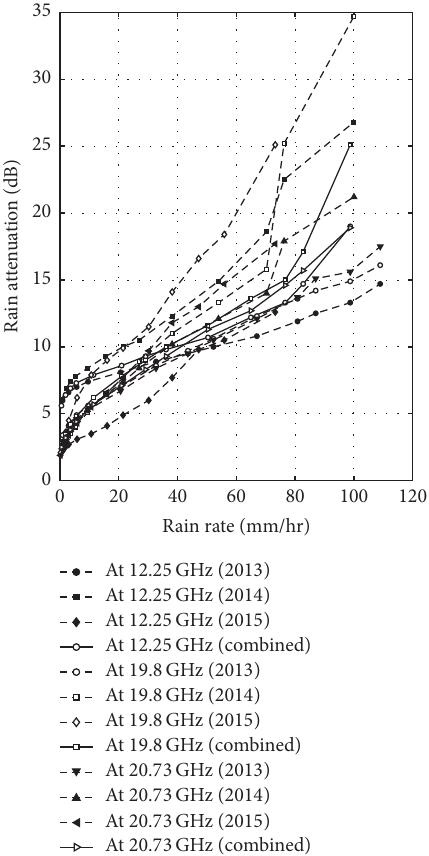
Figure 4: Rain attenuation versus rain rate [19].